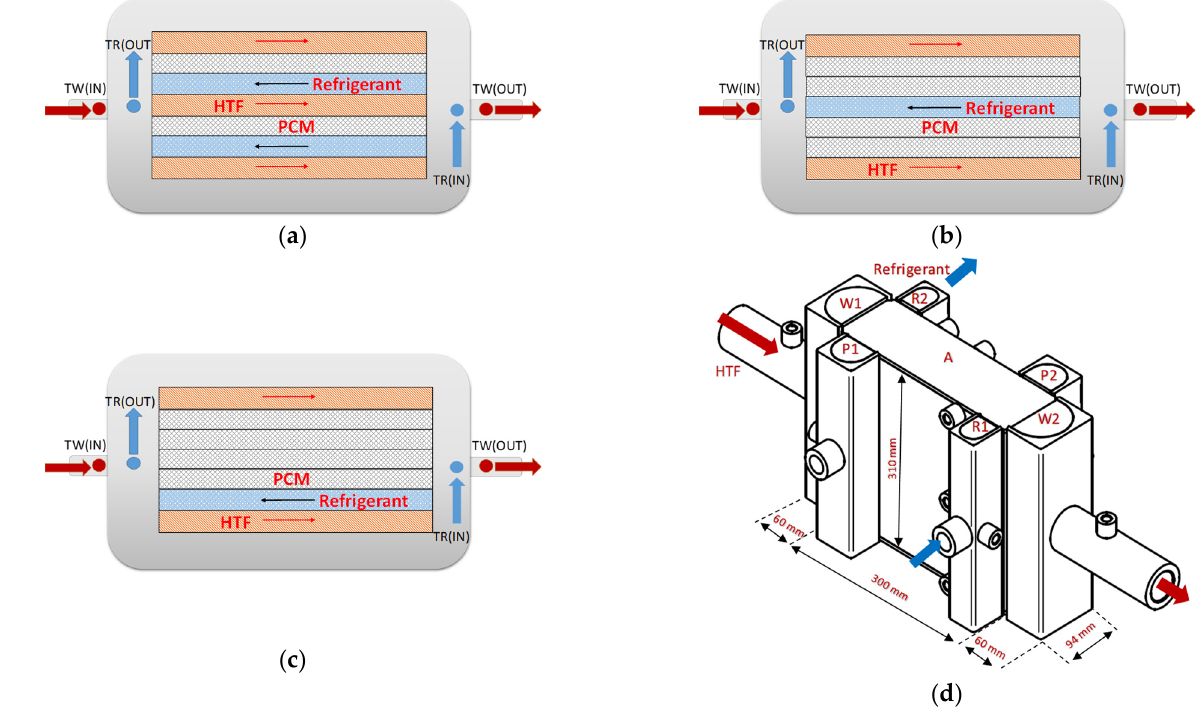
Figure 1. The configuration of the novel evaporator-TES modules: ( a ) TES (cid:2869) , ( b ) TES (cid:2870) , ( c ) TES (cid:2871) , and ( d ) external structure. ( d ) external structure. Table 1. Characteristics of the evaporator-TES